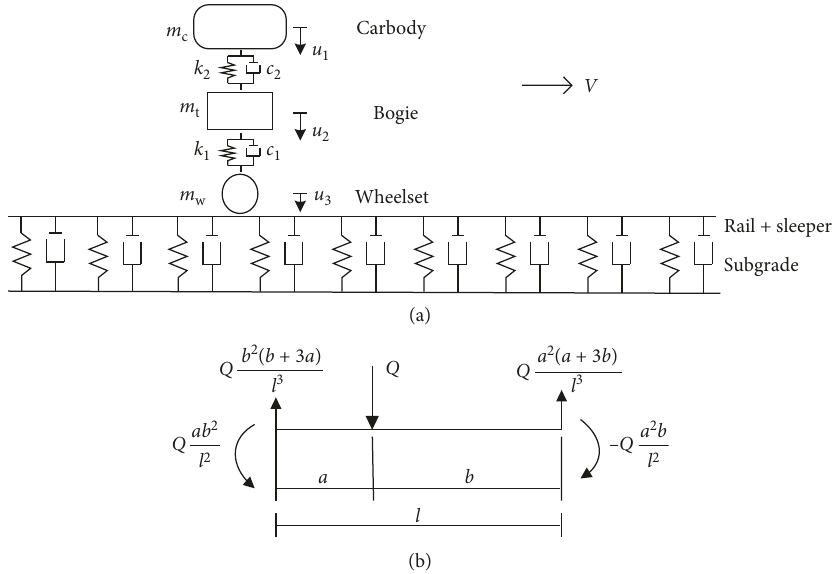
Figure 1: Simplified vehicle-track model: (a) vehicle-track model; (b) equivalent nodal forces acting on a track